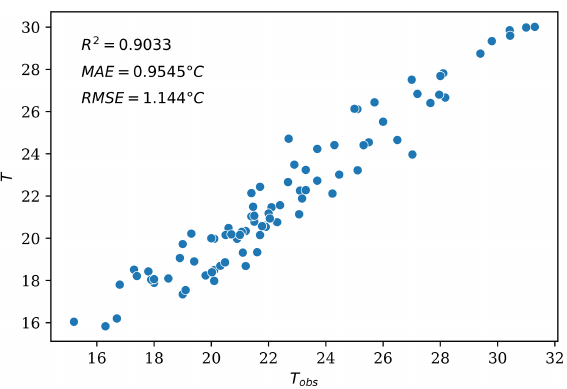
Figure B2. Scatterplot of the T air values simulated with the InVEST urban cooling model ( y axis) versus the observed measurements ( x